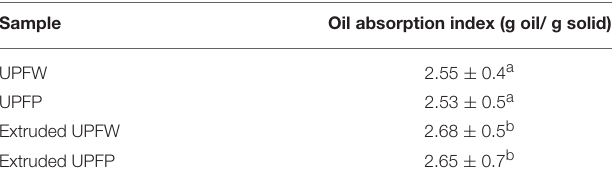
TABLE 3 | Oil absorption index of native and extruded flours of unripe plantain pulp (UPFP) and whole fruit (UPFW). Sample